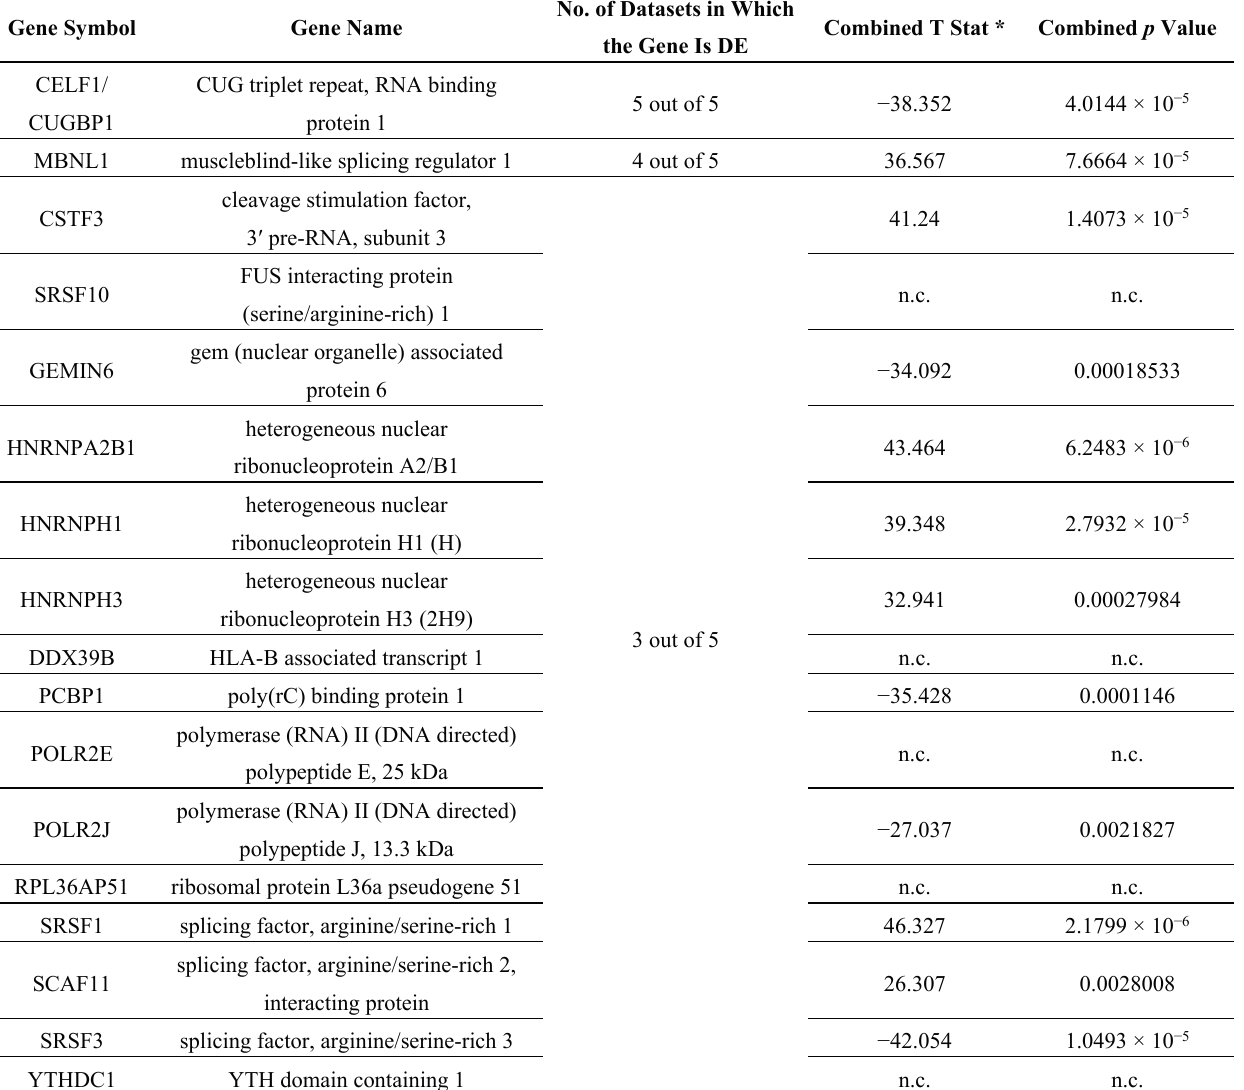
Table 3. The 17 splice-regulatory genes found dysregulated in at least three MS datasets enriched for the gene-ontology category “nuclear mRNA